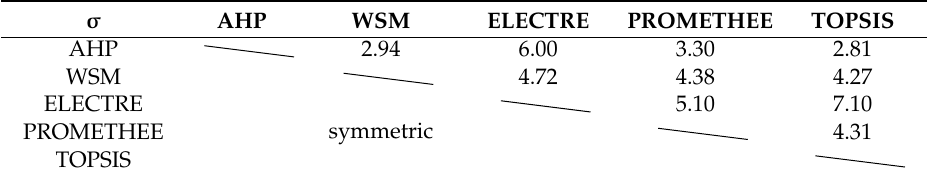
Figure 6. Comparison of the rankings of the sewer system using the different methods: ( a ) for the 10 top ranked street sections; ( b ) the absolute ranking differences with the AHP; ( c ) the absolute ranking differences with the WSM; and ( d ) the absolute ranking differences with ELECTRE and PROMETHEE. Table 5. Standard deviation σ of the sewer ranking between the different used methods.